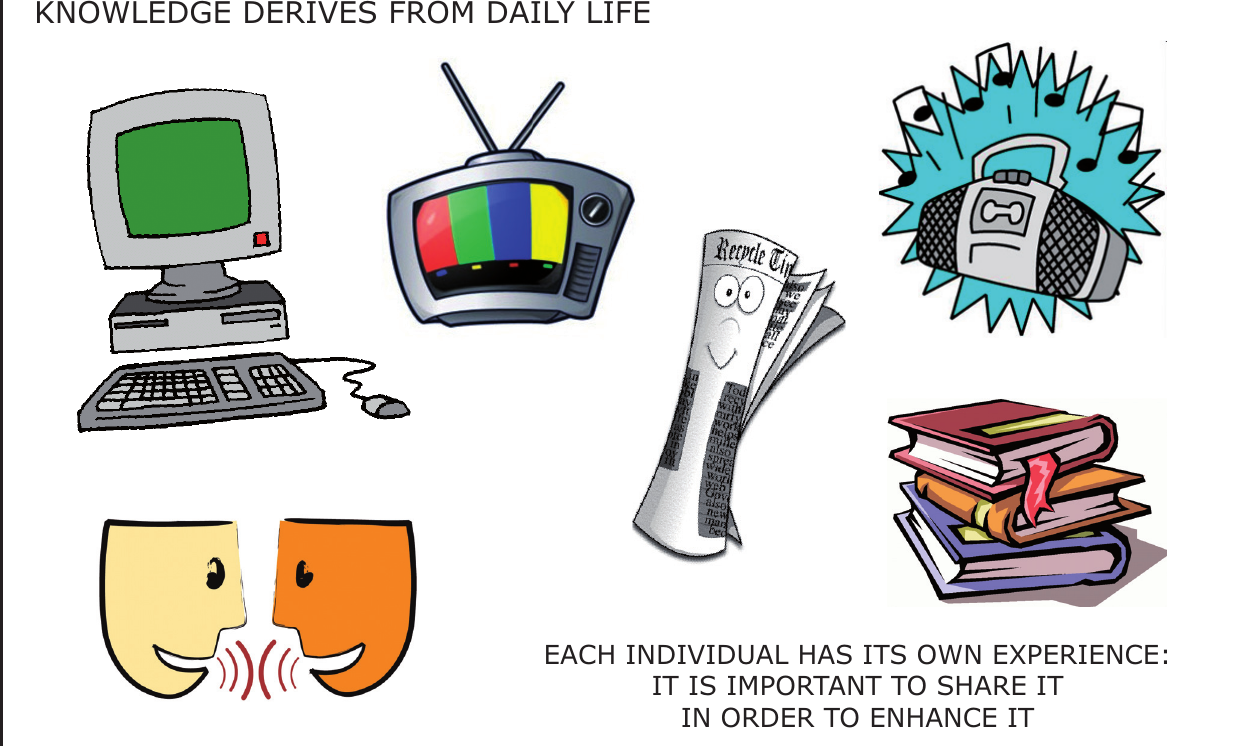
Figure 2 . Main sources of information from daily